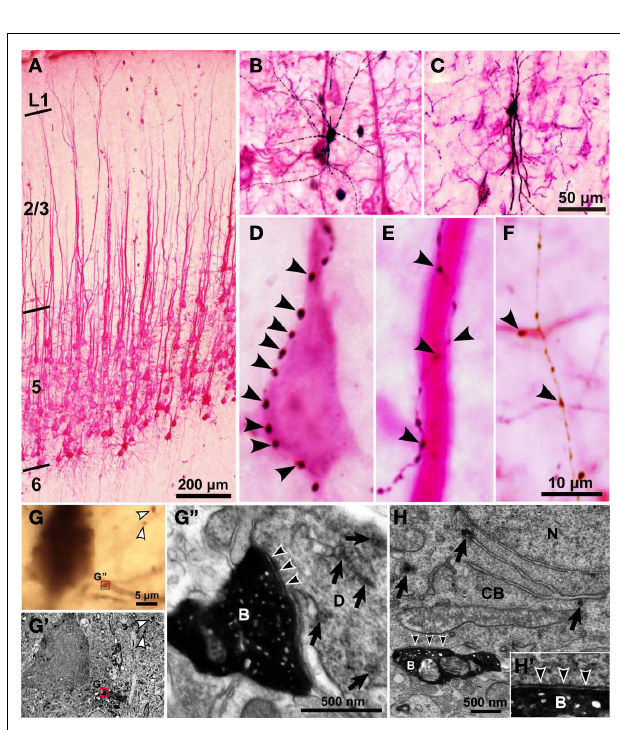
FIGURE 3 | Light and electron microscopic findings of close appositions formed between CSN somata/dendrites and the axons of intracellularly labeled GABAergic interneurons . (A) Retrograde labeling of CSNs after injection into the corticospinal tract ofTMR–DA dissolved in an acidic vehicle. Almost all the dendrites of CSNs were visualized red by immunostaining forTMR with theTAPM/ p -cresol reaction. (B,C) Biocytin-labeled FS (B) and SOM neurons (C) were developed black by the ABC method with the DAB/nickel reaction. (D–F) Many axon boutons of intracellularly labeled interneurons were closely apposed to a cell body [arrowheads in (D) ], a thick apical dendrite (E) and basal or oblique dendrites (F) of CSNs. (G–G (cid:2)(cid:2) ) Some close appositions found in the light microscope were examined electron-microscopically.TMR and biocytin were visualized brown and black with the DAB and DAB/nickel reactions, respectively. Many axosomatic and axodendritic appositions were found to form symmetrical synapses. Black arrowheads in (G (cid:2)(cid:2) ) indicate the symmetric synaptic contact that was made between the biocytin-labeled bouton (B) and the dendrite (D) withTMR immunoreactivity (arrows).White arrowheads in (G) and (G (cid:2) ) point to the boutons that did not contact withTMR-immunopositive structures. (H) Another example of symmetric synapses made on the cell body (CB) containingTMR immunoreactivity (arrows). N, cell nucleus. (H (cid:2) ) High-power view of the synaptic site. Scale bar in (C) applies in (B,C) , that in (F) to (D–F) , that in (G) to (G,G (cid:2) ) , and that in (G (cid:2)(cid:2) ) to (G (cid:2)(cid:2) ,H (cid:2) )